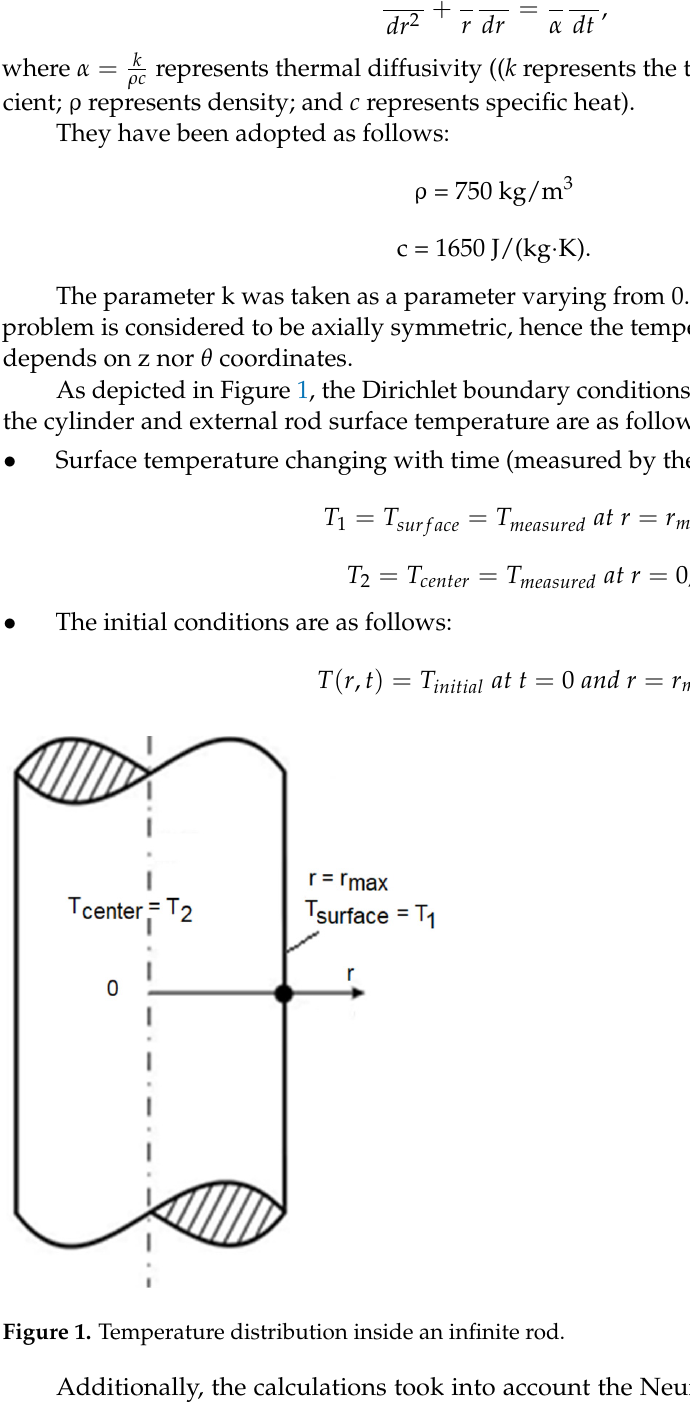
Figure 2. The location of thermocouples in the sample. 2.2.1. Test Procedure The oven was set to a temperature in the range of 100 to 110 °C. After the oven tem- perature had stabilized, the rod specimen was placed inside the oven. The heating exper- iment was carried out for a time that allowed the temperature inside the rod to stabilize. The temperature data were collected continuously by an analog-to-digital converter cou- pled with a data logger and a computer. In Figure 2, the schematic diagram of the con- structed system for the heating experiment is presented. The cooling experiment was con- ducted outside the oven. The heated rod was removed from the oven and hung on threads, maintaining the same configuration as in the heating experiment. The rod was subjected to free air convection and ambient temperature conditions to cool the rod sam- ple. 2.2.2. Heating and Cooling Tests The normalized temperature was introduced to make a comparison between tests which can vary with respect to the final temperature. The normalized temperature for heating tests was calculated using Equation (9): 𝜃 (cid:3035) = (cid:3021)((cid:3045),(cid:3047))(cid:2879)(cid:3021) (cid:3284)(cid:3289)(cid:3284)(cid:3295)(cid:3284)(cid:3276)(cid:3287) (cid:3021) (cid:3246) (cid:2879)(cid:3021) (cid:3284)(cid:3289)(cid:3284)(cid:3295)(cid:3284)(cid:3276)(cid:3287) , (9) where: T initial represents the temperature for t = 0,